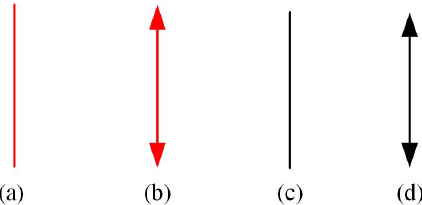
Figure 1. Freedom and constraint line. (a) Rotation freedom. (b) Translation freedom. (c) Force constraint. (d) Moment con- straint.